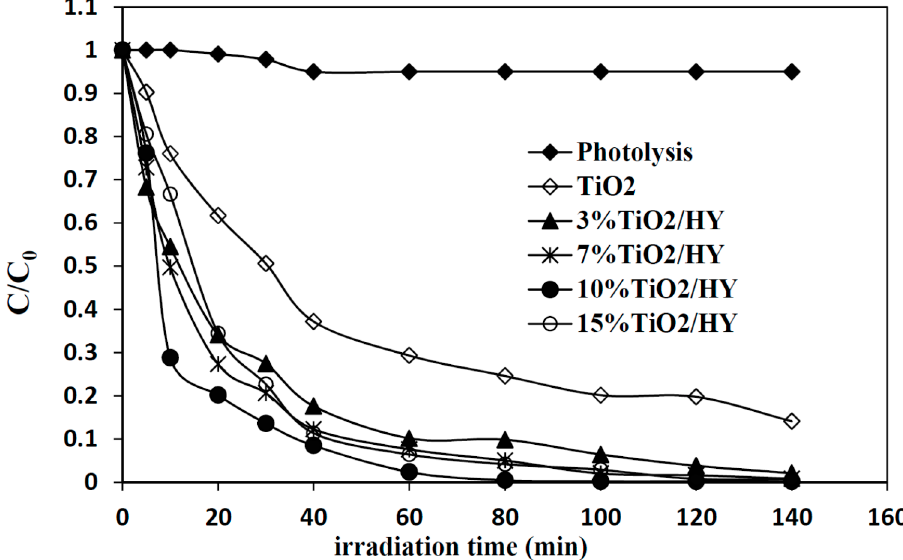
Figure 6. Photocatalytic degradation of MB over TiO 2 supported HY zeolite at different TiO 2 loadings under UV irradiation ( λ max = 254 nm, dye concentration = 20 mg L − 1 , zeolite amount = 1 g L − 1 , T = 25 °C).